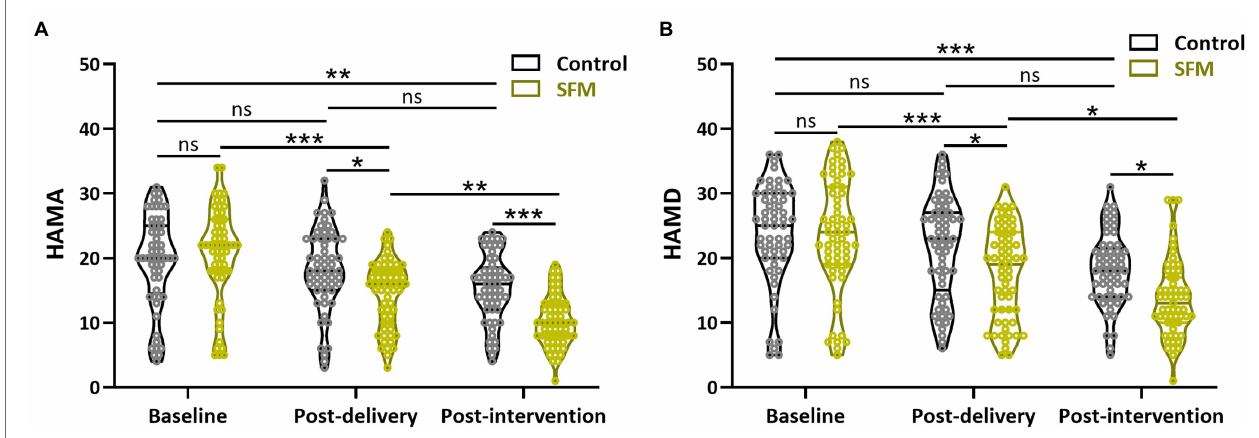
FIGURE 4 | Assessment of Hamilton Anxiety Rating Scale (HAMA; A ) and Hamilton Depression Rating Scale (HAMD; B ) between the two groups at different time points. Values were presented with violin plot showing all the data. * p < 0.05, ** p < 0.01, *** p < 0.001, and ns, no significance. Two-way ANOVA test followed by Turkey multiple comparisons